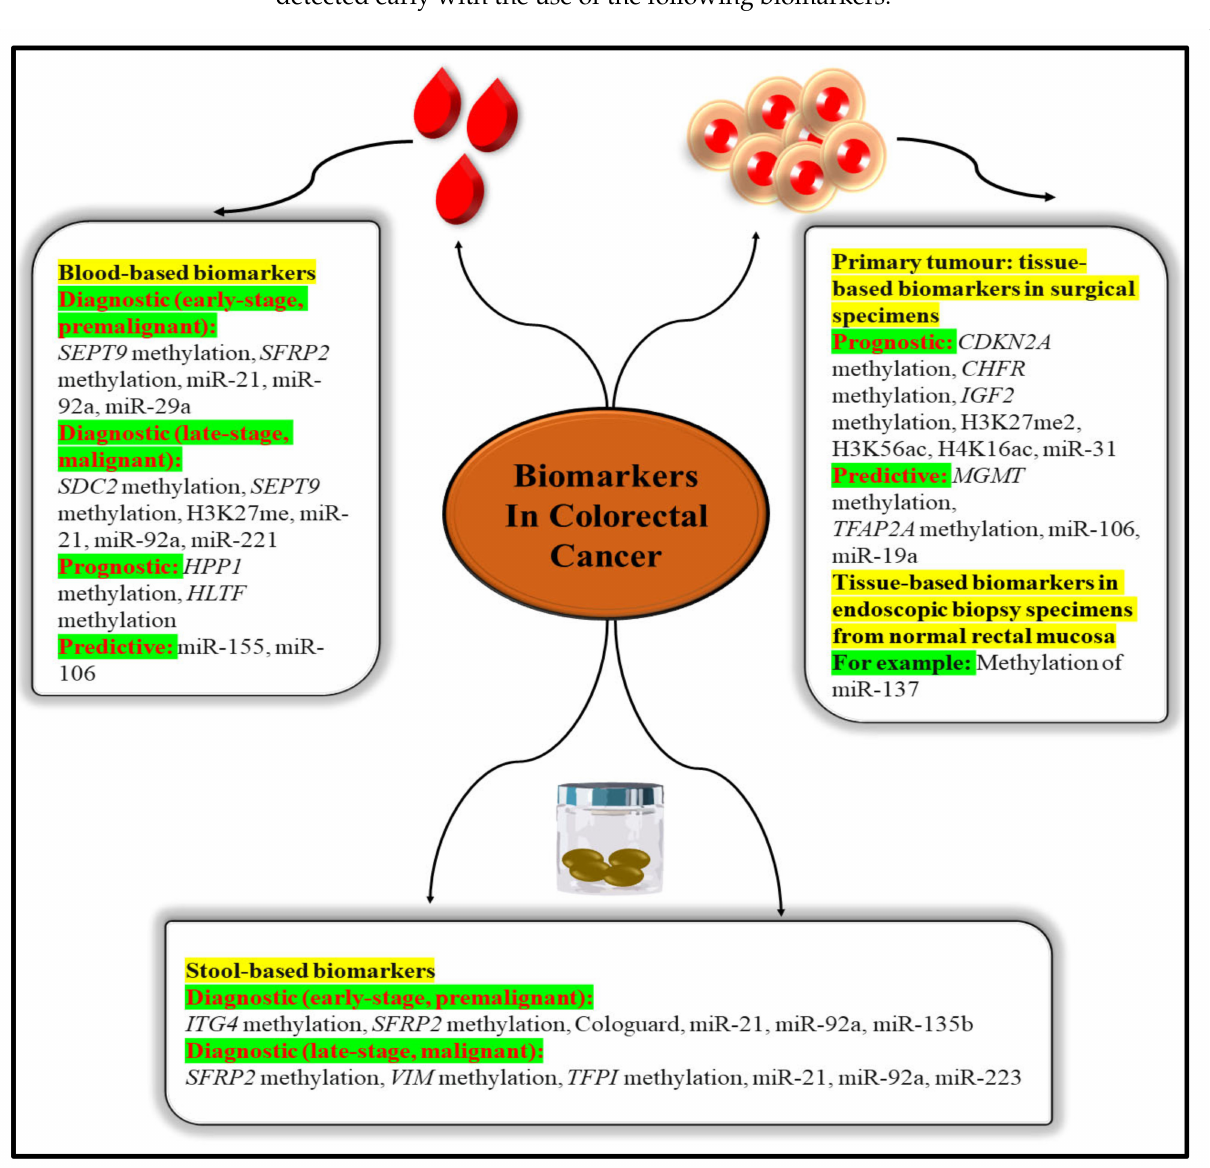
Figure 5. Epigenetic biomarkers in